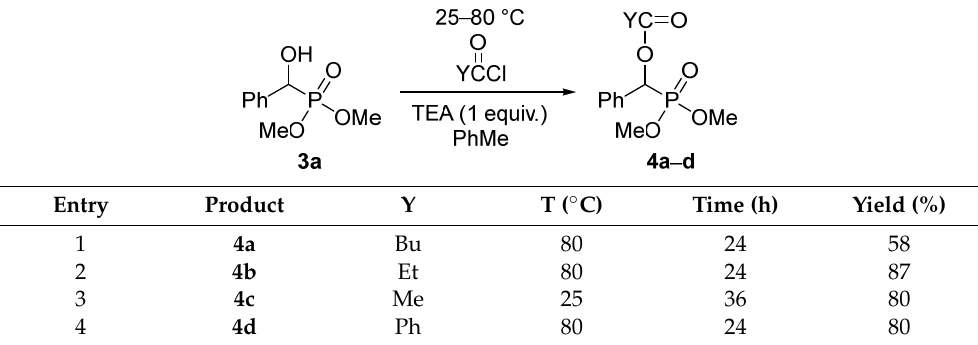
Table 3. The acylation of dimethyl α -hydroxy-arylmethylphosphonates ( 3a